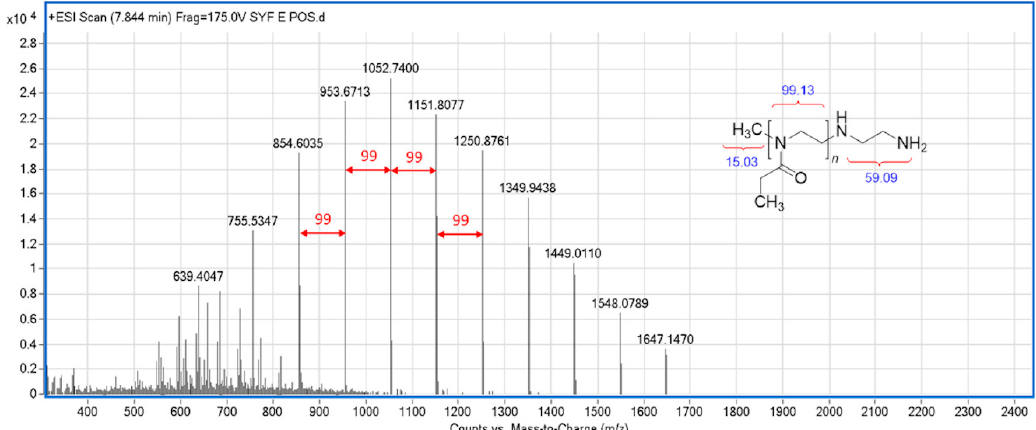
Figure 2. Mass spectrometric analysis of amine-end functionalized PEtOx (PEtOx-NH 2 ) showing a regular separation of 99 Da corresponding to the molecular weight of an EtOx repeating unit. The red arrows indicate the regular separation of 99 Da, corresponding to the molecular mass of an EtOx repeating unit. The blue numbers are the mass (in Da) of the respective chemical groups.